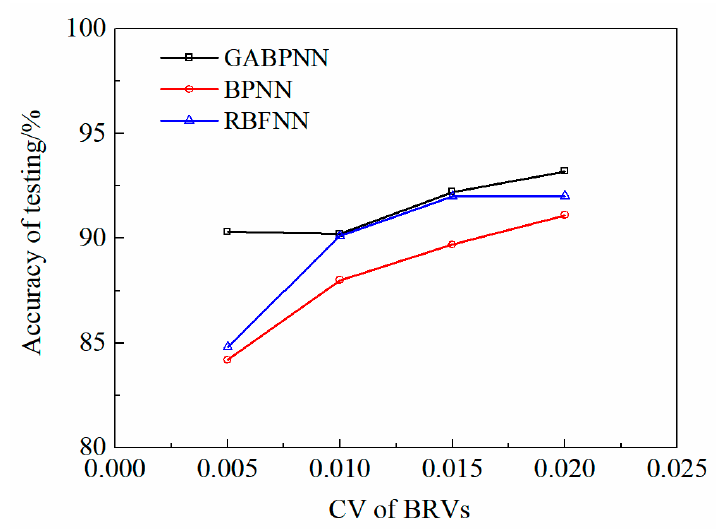
Figure 6. The comparison of the testing accuracy of the ANNs in the IP study under the shock load condition where v is 1050 m/s.